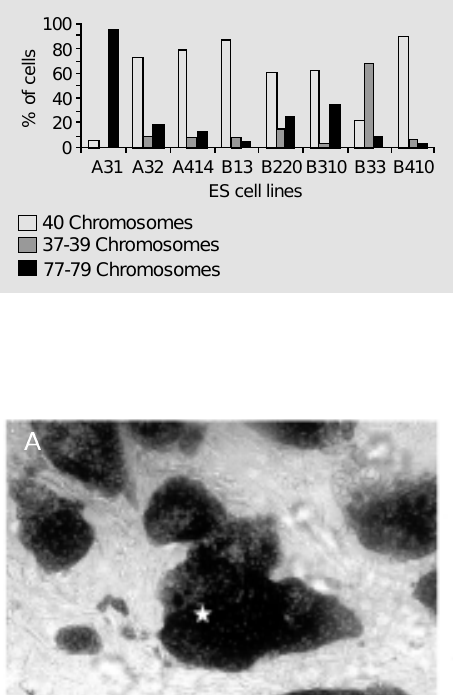
Figure 1. Number of chromo- somes in embryonic stem (ES) cell lines determined by cytoge- netic